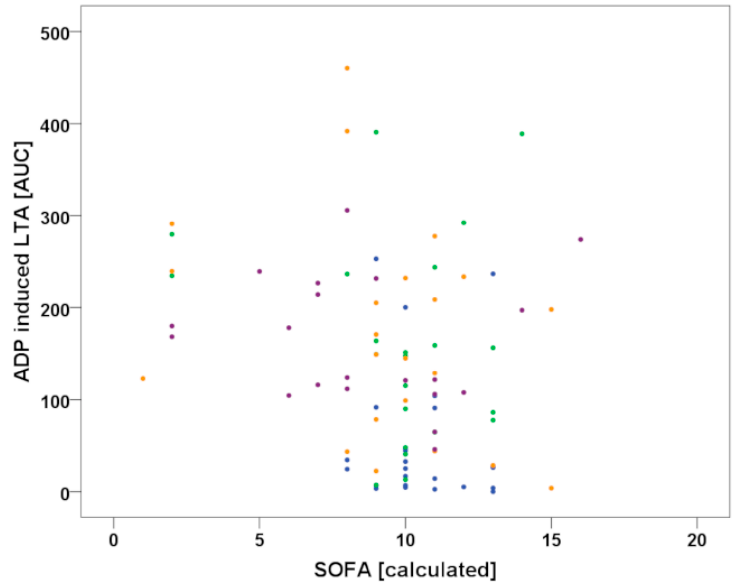
Figure 3. Correlation of SOFA score with ADP-AUC. Data of the 25 patients of the CANGRELOR group is shown. Day 1 (blue), day 2 (green), day 3 (orange), and day 4 (purple) had no differences. Overall data showed r = − 0.076; p = 0.623).